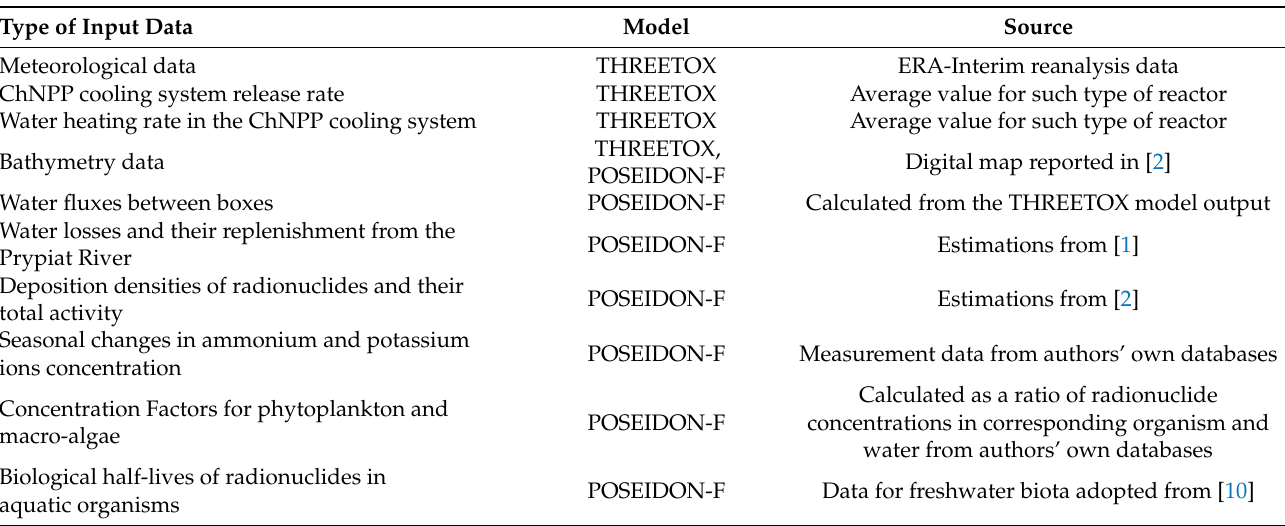
Table 1. List of input data and their sources used in